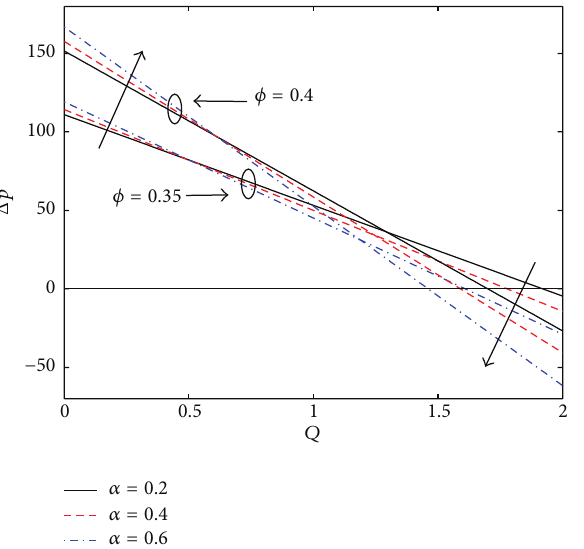
Figure 7: Pressure rise Δ𝑝 versus the time-averaged flow rate 𝑄 for different values of the parameter 𝛼 1 and amplitude ratio 𝜙 with Gr = = 1 , and 𝑡 = 1 . 3 , 𝜀 = 0.35 , 𝛽 = 10 , 𝜆 1